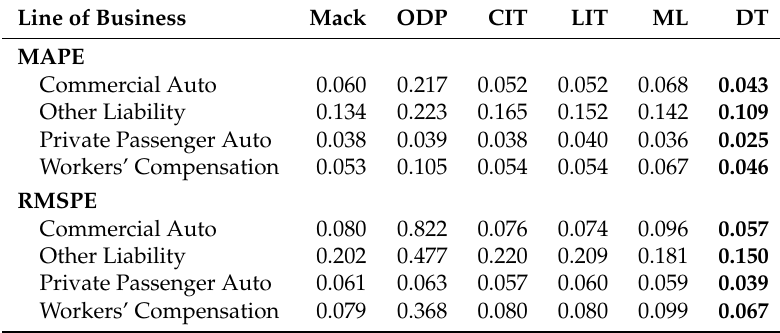
Table 1. Performance comparison of various models. DeepTriangle and AutoML are abbreviated to DT and ML, respectively. The best metric for each line of business is in